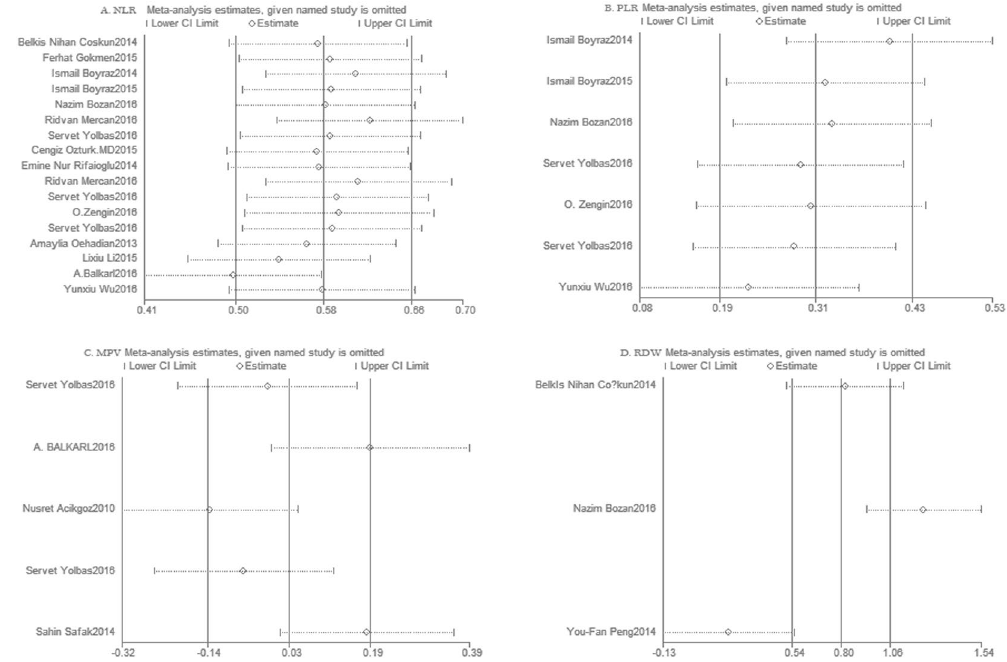
Figure 6. Sensitivity analysis of included studies. NLR and ARDs ( A ), PLR and ARDs ( B ), MPV and ARDs ( C ), and RDW and ARDs ( D